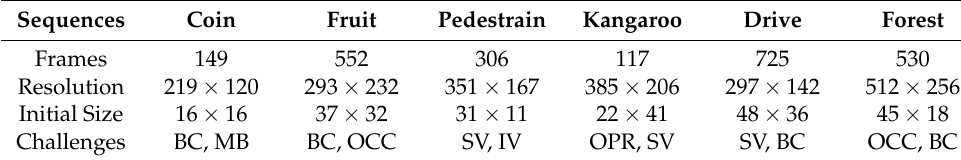
Figure 10. Six RGB experiments. Table 1. Details of the six experimental